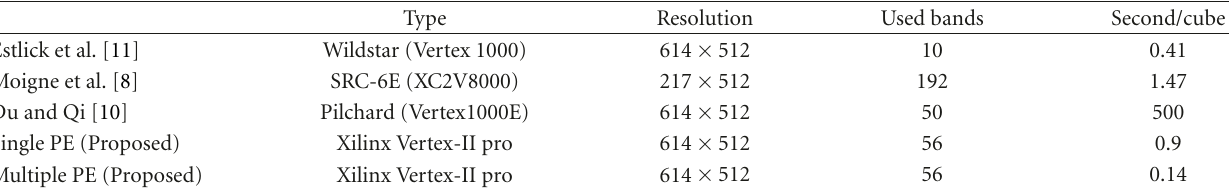
Figure 14: Block diagram in multiple data partitioning without separated library. Table 1: Throughput comparison.